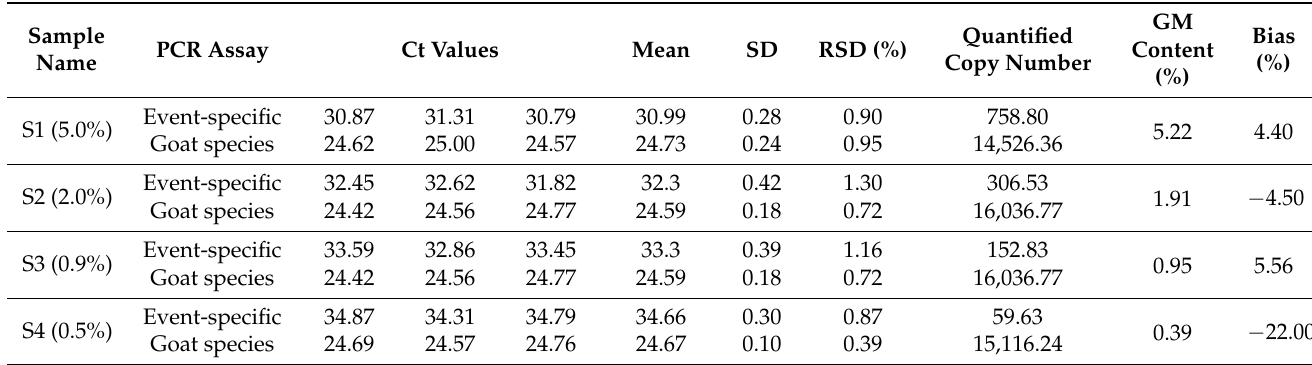
Table 3. Quantification of simulated blood samples using the developed event-specific real-time PCR assay. Sample